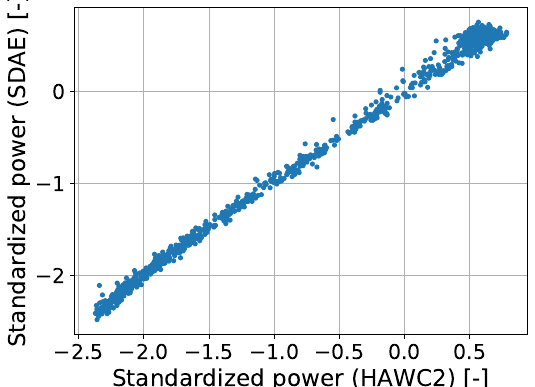
−2.5 −2.0 −1.5 −1.0 −0.5 0.0 0.5 Figure 15. Standardized power estimated by SDAE on test set with respect to normalized power